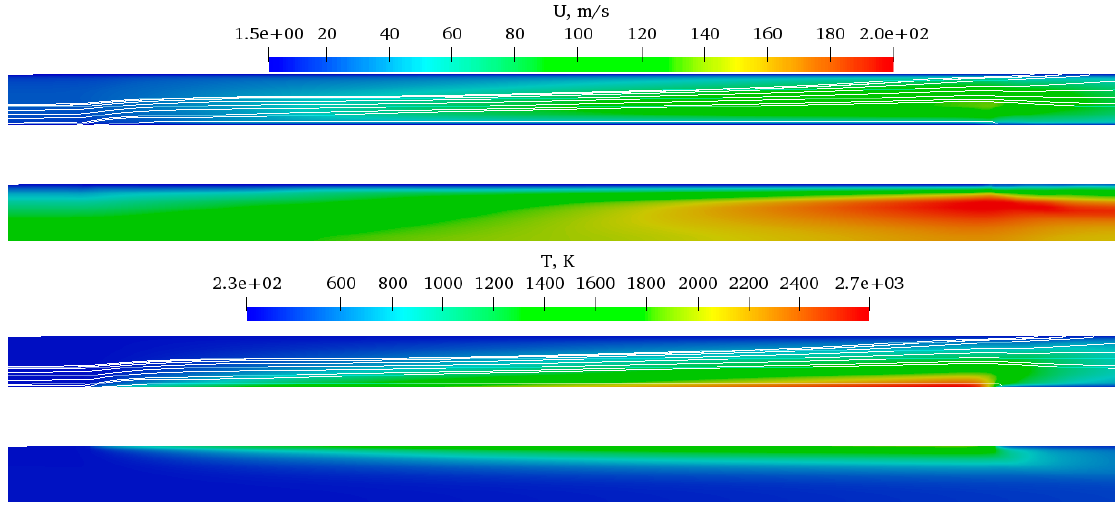
Figure 12. Temperature and velocity distribution around the batteries in the duct for the 100 Pa case.